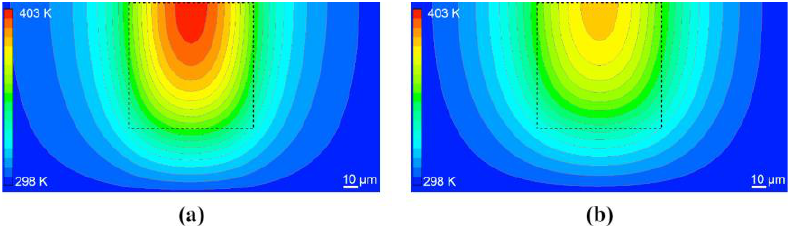
Figure 11. MLL temperature distribution in MMLs of geometry G2b consisting of ( a ) Be/SiC and ( b )